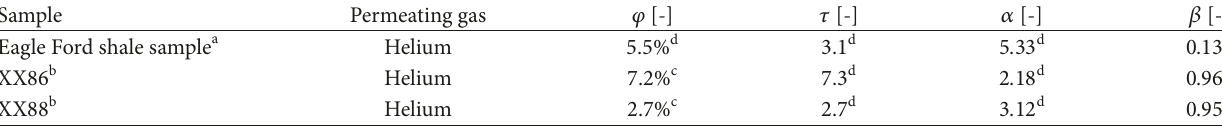
Table 1: Fitted parameters of the apparent permeability model.